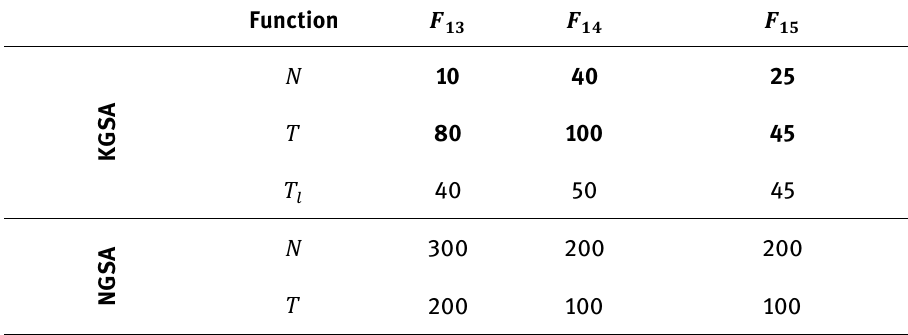
Table 7A: List of required parameters for discovering global optima in Table